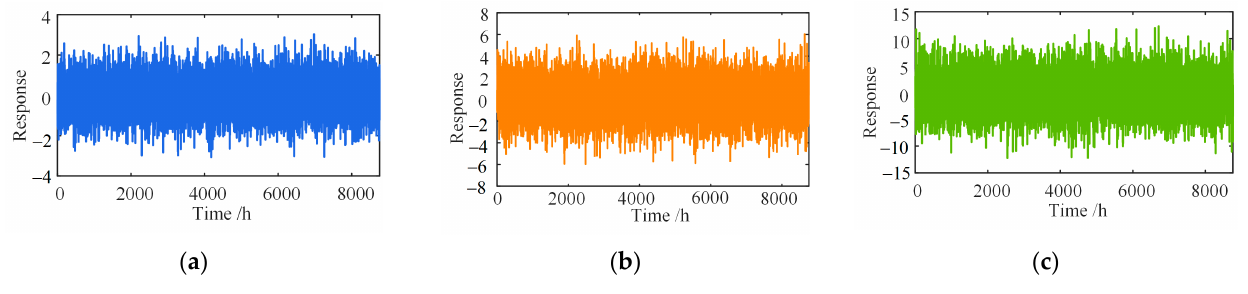
Figure 12. Different degrees of noise (one year): ( a ) e p = 5%; ( b ) e p = 10%; ( c ) e p =